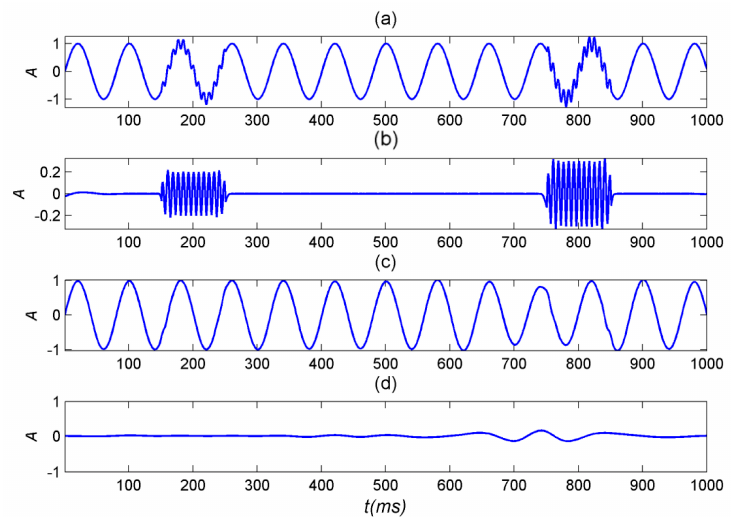
Figure 2. Analysis results of the simple artificial signal using complementary ensemble empirical mode decomposition (CEEMD): ( a ) the signal; ( b ) IMF1 of the signal; ( c ) IMF2 of the signal; and ( d ) IMF3 of the signal.